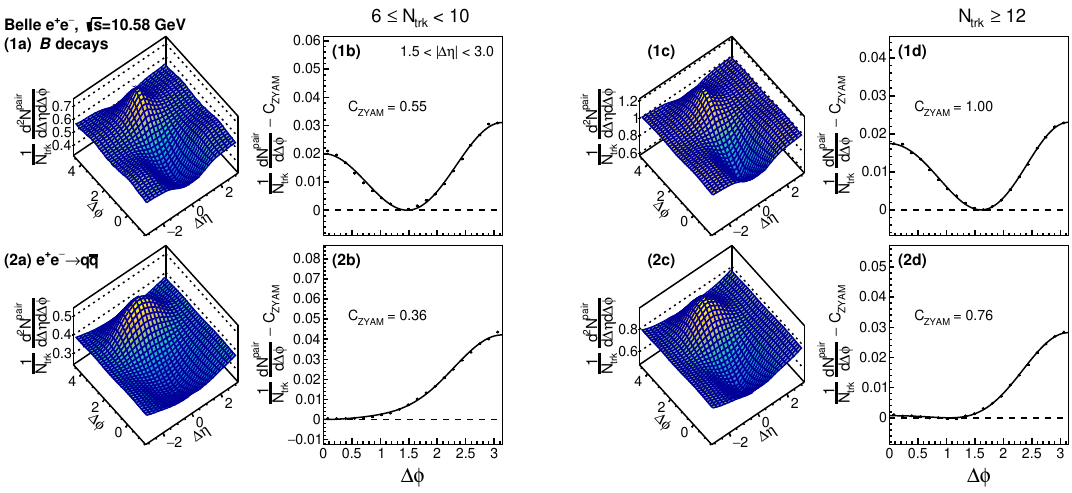
Figure 12. Two-particle correlation functions and long-range ( 1 . 5 ≤ | ∆ η | < 3 . 0 ) ZYAM-subtracted azimuthal differential associated yields for separated MC sources with the Belle MC. Panels (1a)-(1d) are results with B -meson decays and panels (2a)-(2d) are those from q ¯ q fragmentation, in which (a) and (b) show the lower multiplicity results with 6 ≤ N 10 ; (c) and (d) show the higher trk < multiplicity ones with N 12 . The long-range near-side enhancements are seen specifically in the trk ≥ B decays MC sample in both the low- and high-multiplicity